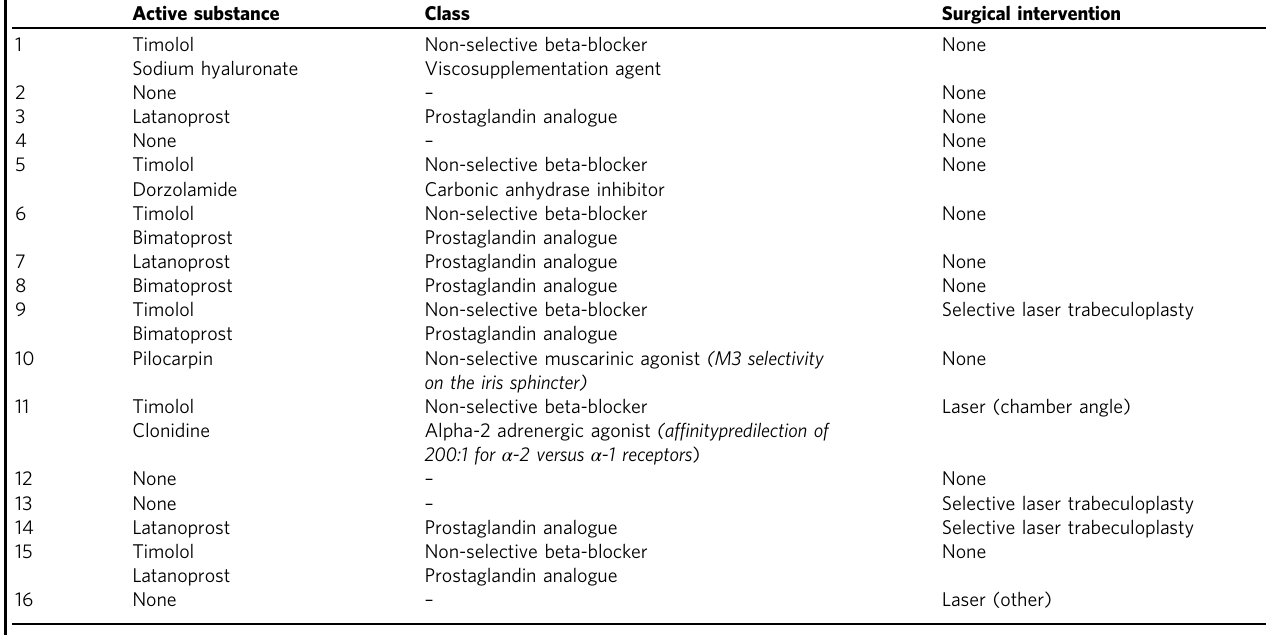
Table 2 Eye drop medication and surgical eye intervention in each participant with ocular